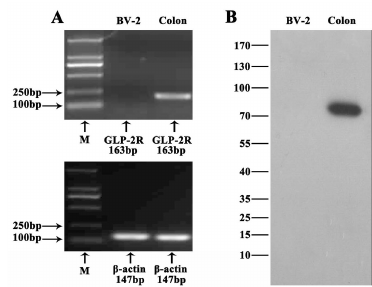
Figure 3. Expression of GLP-2R in BV-2 cells. ( A ) RT mixtures from colon (positive control) and BV-2 cells were analyzed to detect GLP-2R mRNA expression by PCR. The PCR products were visualized by 2% agarose gel electrophoresis. GLP-2R was detected in colon but not in BV-2 cells; ( B ) Western blotting of GLP-2R in colon and BV-2 cells. GPR109A was detected in colon but not in BV-2 cells.